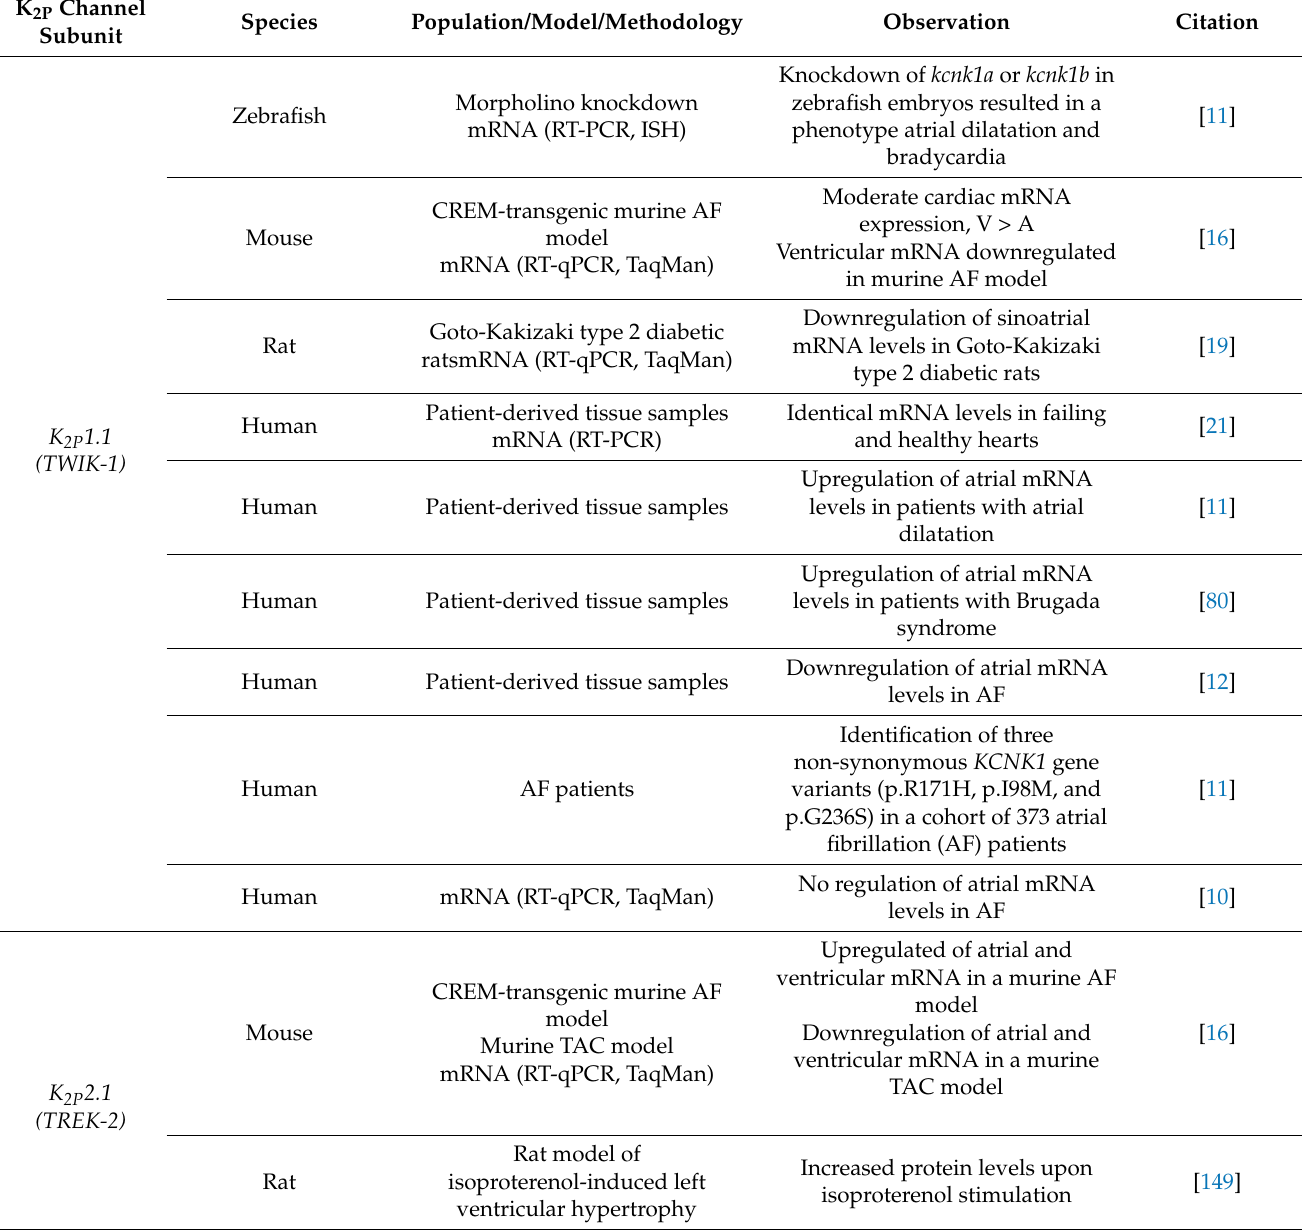
Table 4. Functional evidence for K 2P channel expression in the cardiovascular